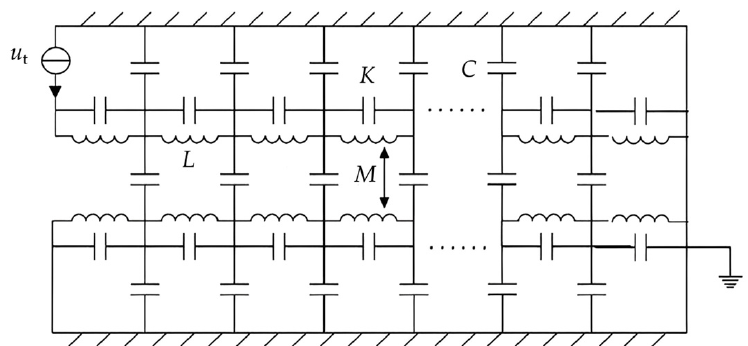
Figure 2. Equivalent circuit of HFT winding.